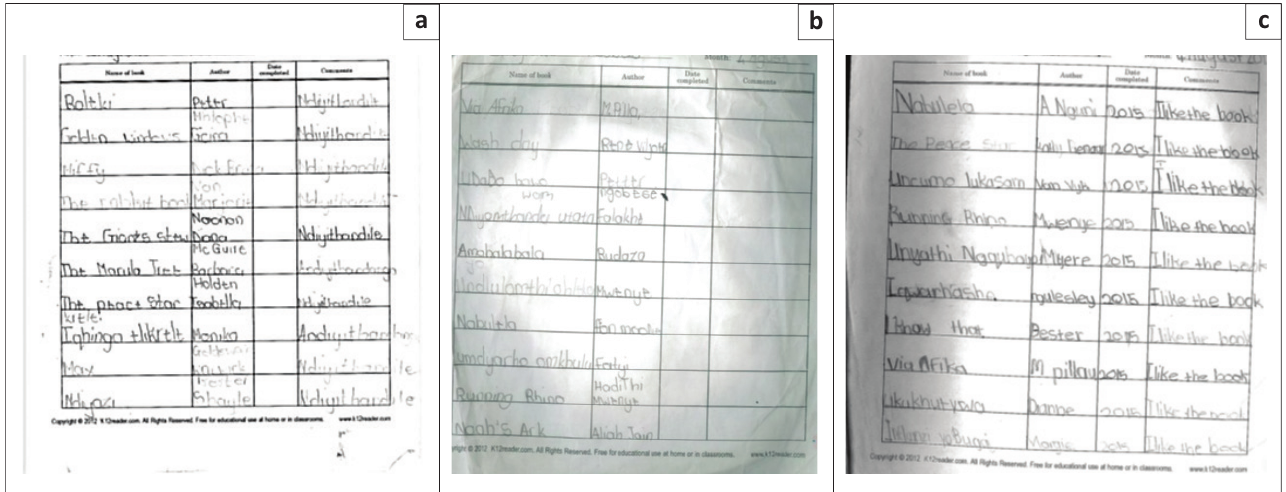
FIGURE 2: Learners’ reading logs: (a and b) example 1 (c) example